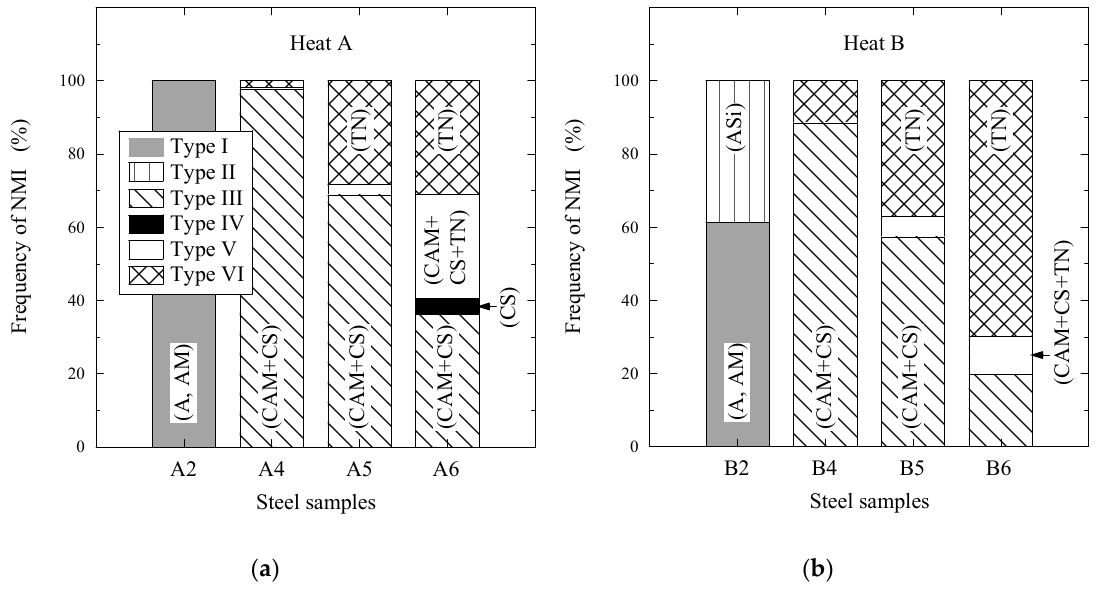
Figure 5. Di ff erent types of inclusions observed in steel samples: ( a ) Heat A; ( b ) Heat Figure 5. Different types of inclusions observed in steel samples: ( a ) Heat A; ( b ) Heat B.